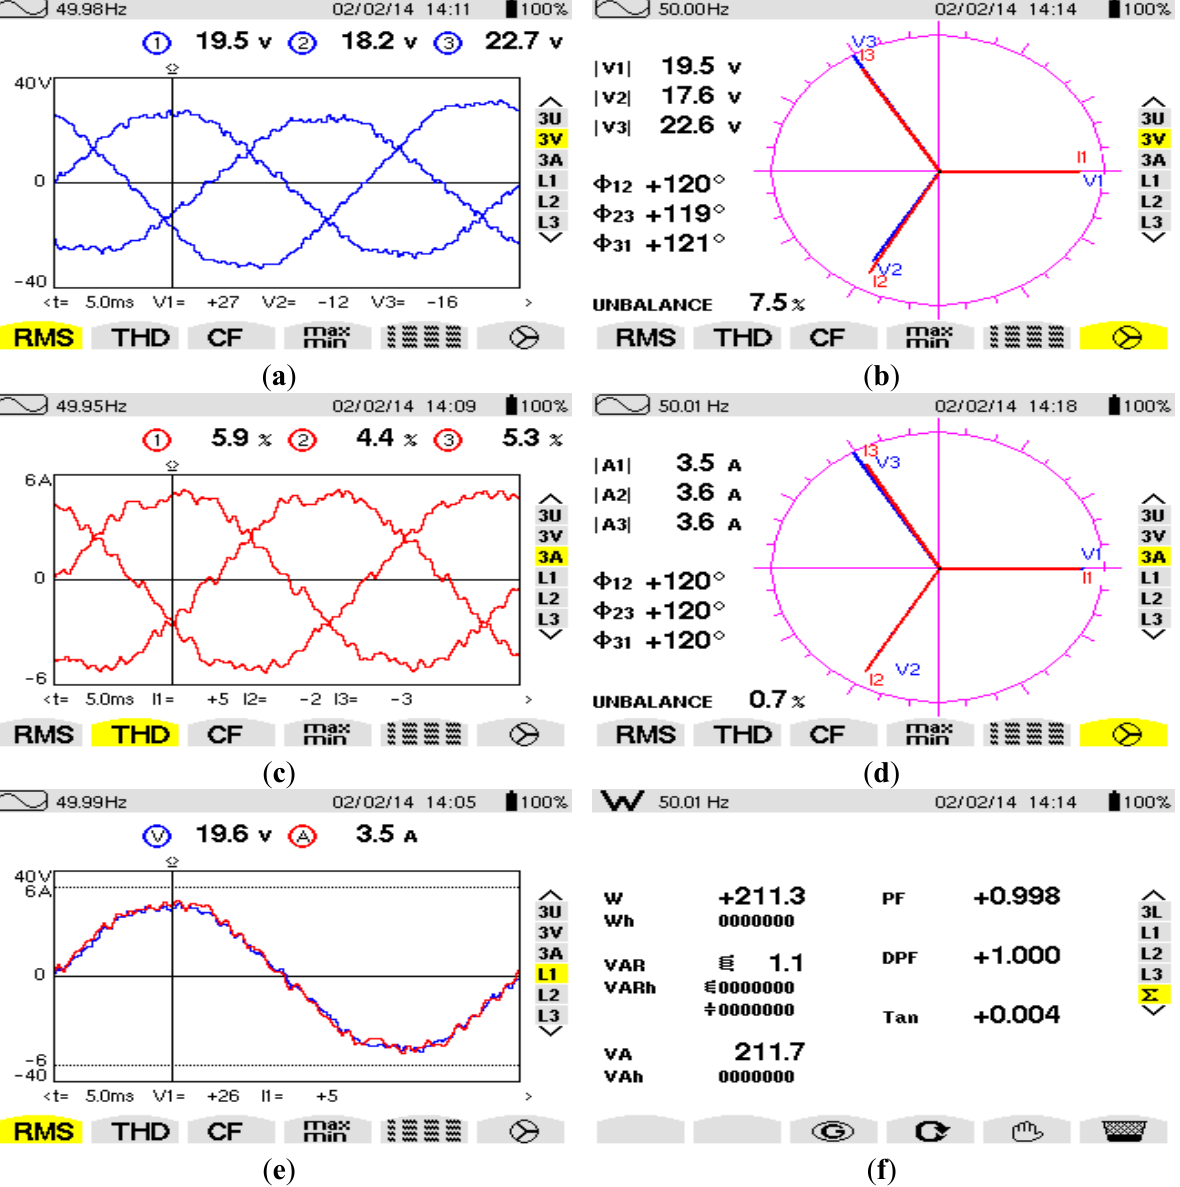
Figure 18. Experimental results of unbalanced sinusoidal grid voltage: ( a ) three-phase line voltage with THD; ( b ) Vector diagram of line voltage and current; ( c ) three-phase line currents with THD after filtering; ( d ) Vector diagram of line voltage and current; ( e ) line voltage and current, phase-a; ( f ) characteristic and power balance sheet of the grid after